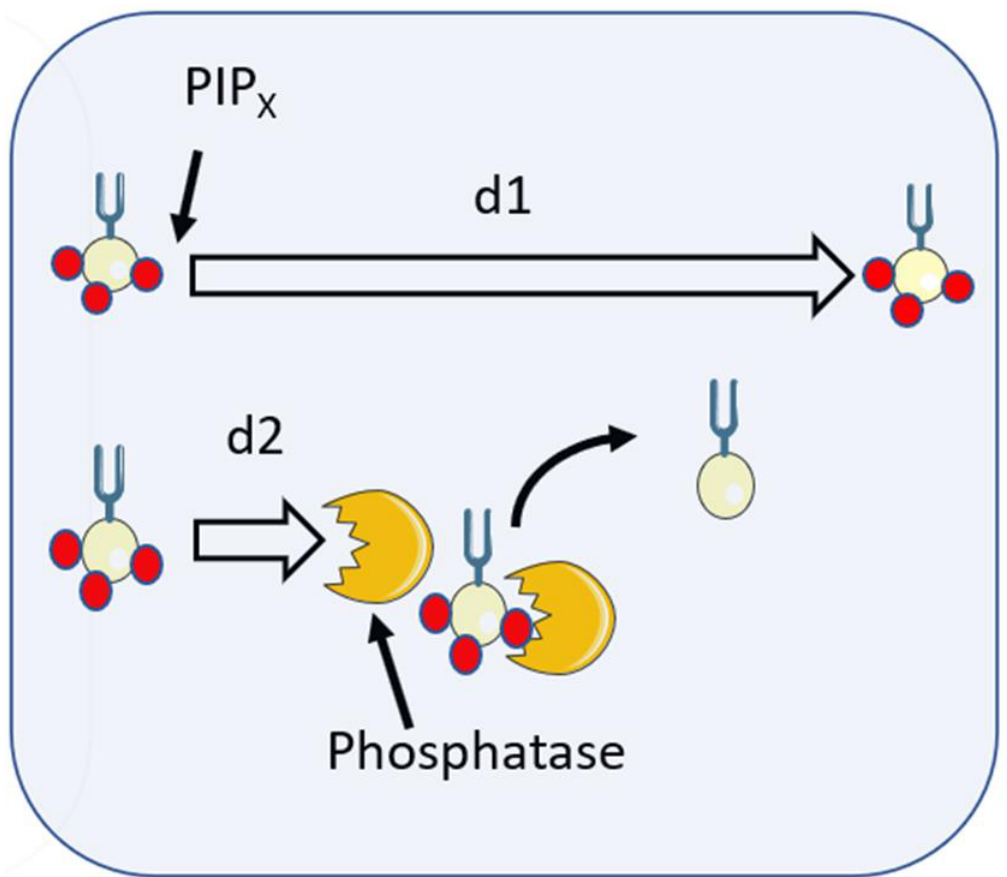
Figure 5. PIPx interactions with inositol phosphatases limit diffusion length.